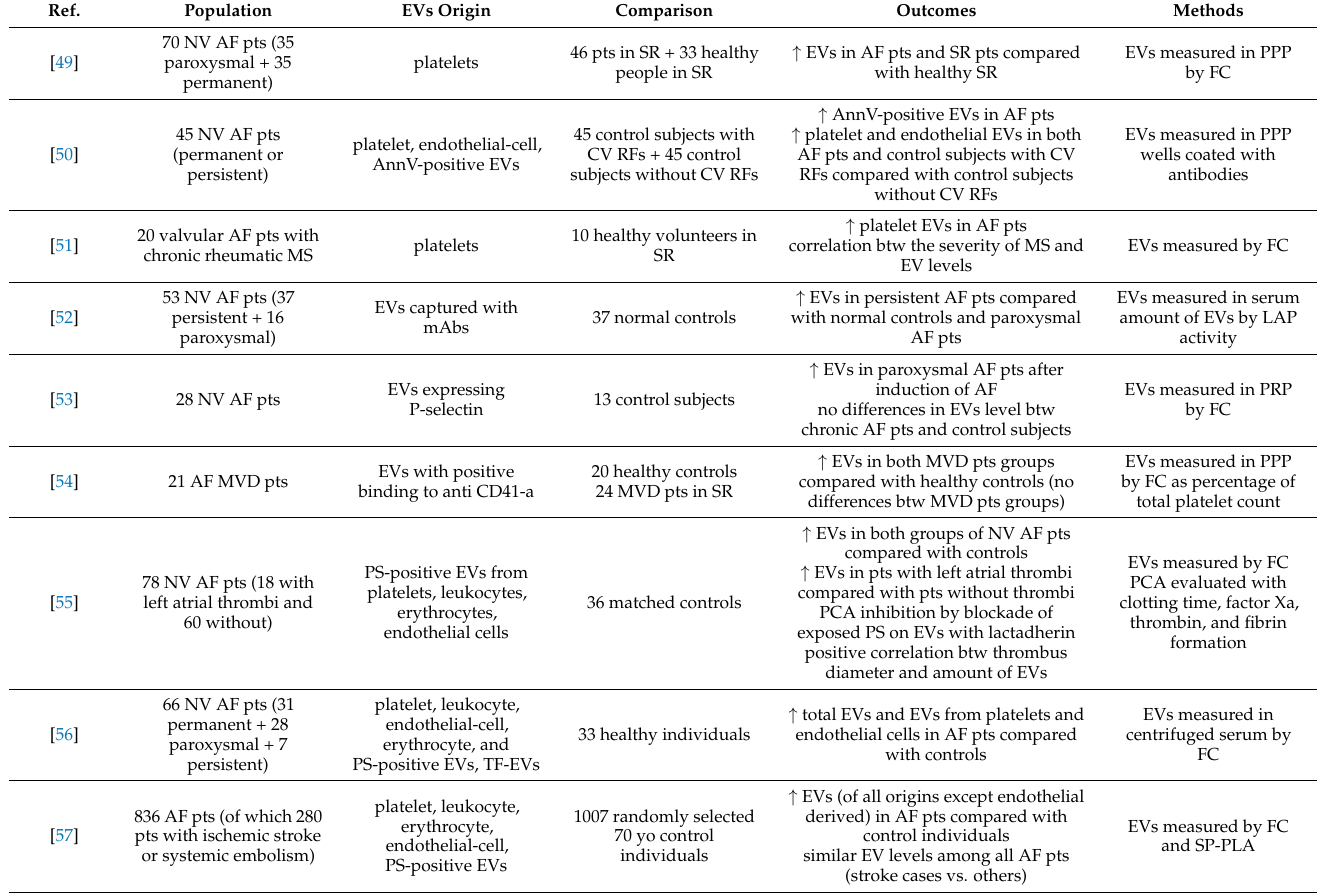
Table 4. Summary of other research studies concerning extracellular vesicles in atrial fibrillation